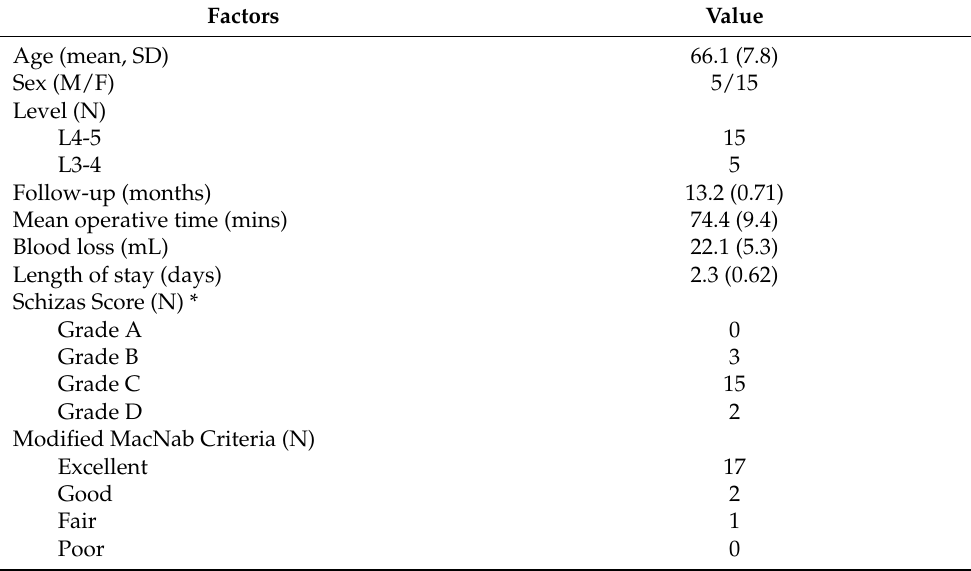
Figure 3. Patient flowchart for inclusion and exclusion selections. Table 1. Patient demographics and surgical and hospital characteristics.